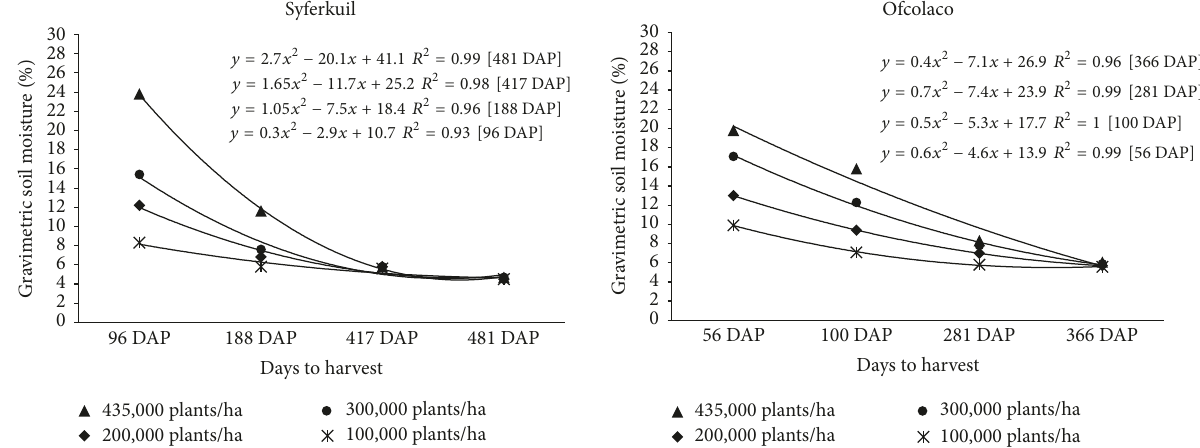
Figure 4: Influence of planting density on gravimetric soil moisture percentage at different harvest intervals at Syferkuil and Ofcolaco across all seasons. Note . DAP: days after